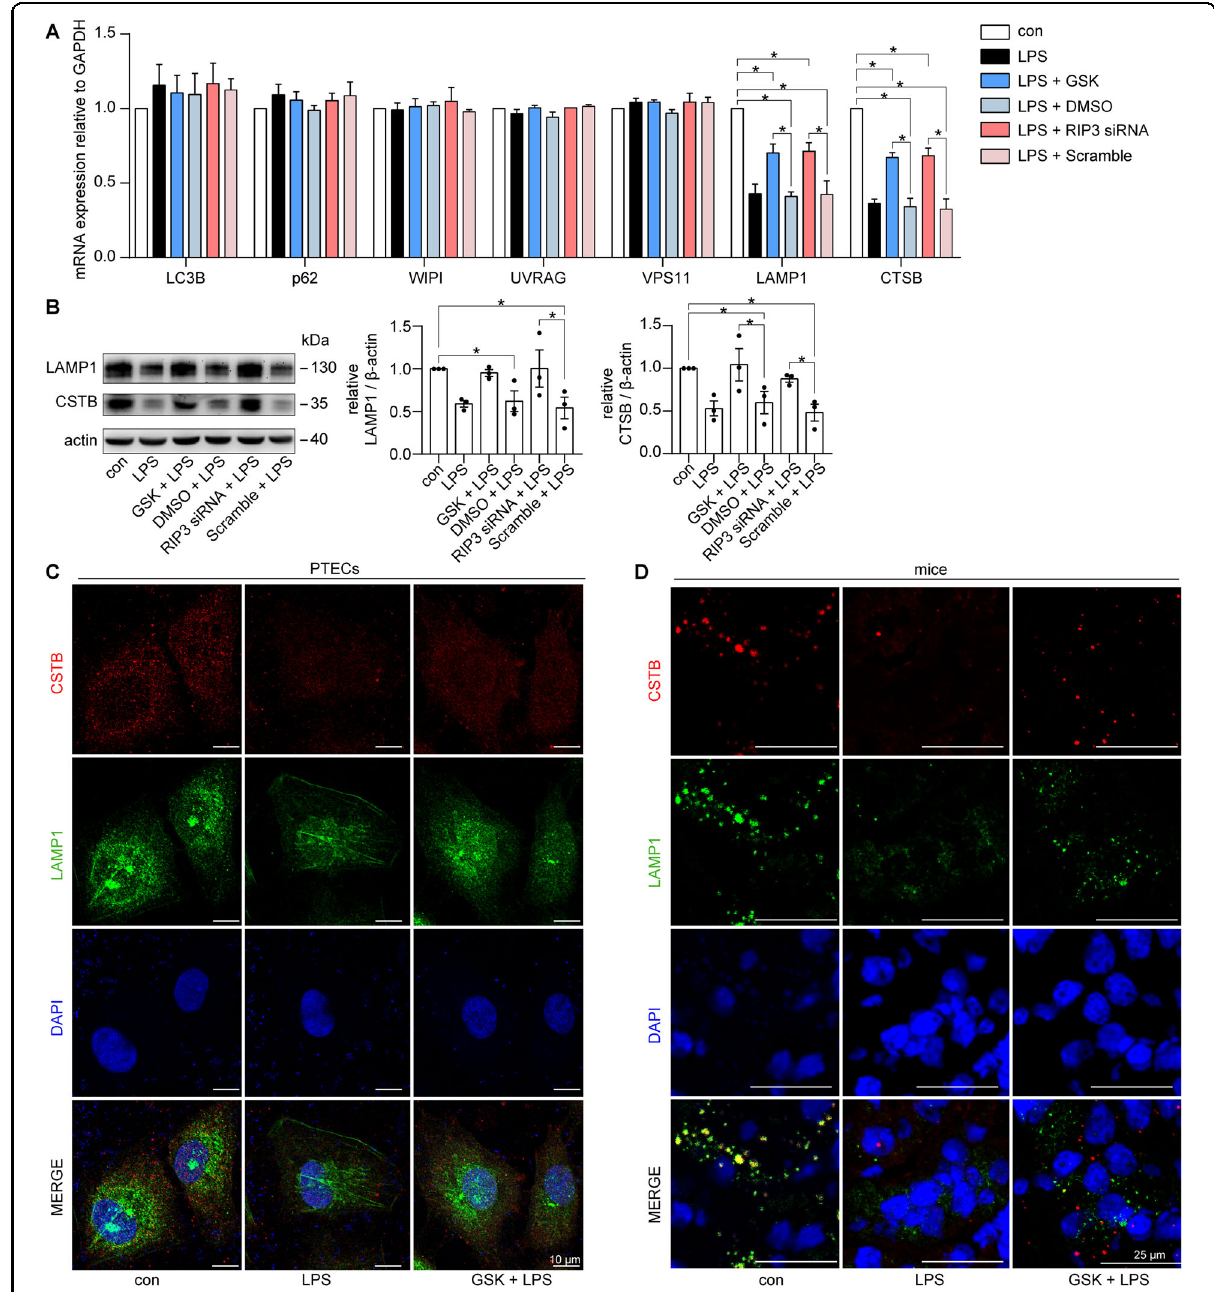
Fig. 6 The expression of LAMP1 and CTSB was suppressed by RIP3 in LPS-induced cultured PTECs and septic AKI mice. A RT-qPCR analyses of the expression of potential TFEB target genes in cultured PTECs treated with LPS, LPS plus GSK ’ 872 (GSK), LPS plus DMSO, LPS plus RIP3 siRNA, or LPS plus scrambled siRNA (Scramble) for 12 h. The mRNA levels of LAMP1 and CTSB were inhibited by LPS, which was restored by GSK or RIP3 siRNA ( n = 3). B Immunoblotting showed that the protein levels of LAMP1 and CTSB was decreased by LPS, which was restored by GSK ’ 872 or RIP3 siRNA in cultured PTECs treated as indicated for 24 h ( n = 3). C Immuno fl uorescence staining for CTSB (red), LAMP1 (green), and DAPI (blue) in cultured PTECs treated as indicated for 24 h. GSK restored the decreased expression of CTSB and LAMP1 in LPS-treated PTECs. Scale bar = 10 μ m. D Immuno fl uorescence staining for CTSB (red), LAMP1 (green), and DAPI (blue) in the kidneys from C57BL/6 mice treated with vehicle (con), LPS, or LPS plus GSK for 24 h. The expression of CTSB and LAMP1 were suppressed in the renal tubular cells of LPS-induced mice, which were partially restored by GSK. Scale bar = 25 μ m. * P <